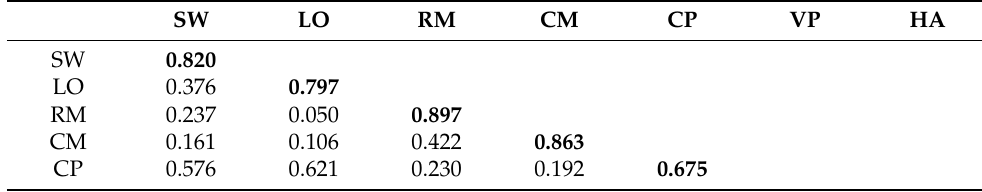
Table 3. Discriminant